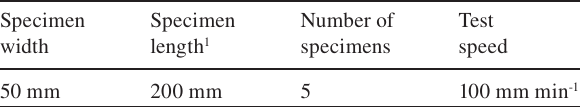
Table 3 Experimental conditions used on the tensile tests.